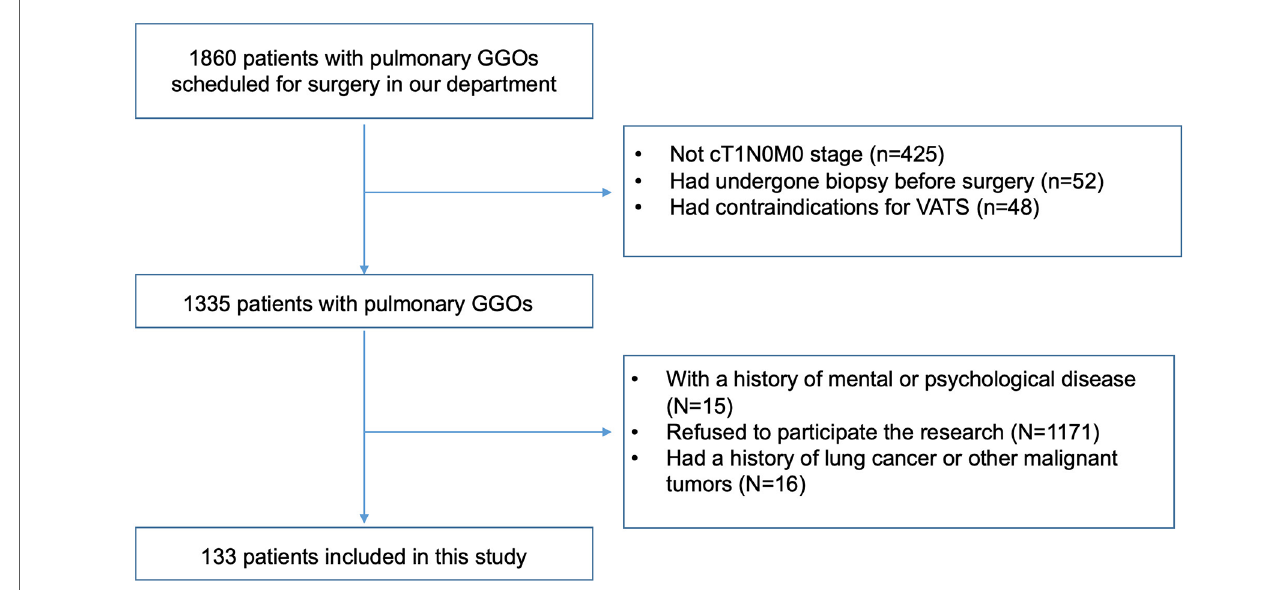
FIGURE 1 Flow chart of the